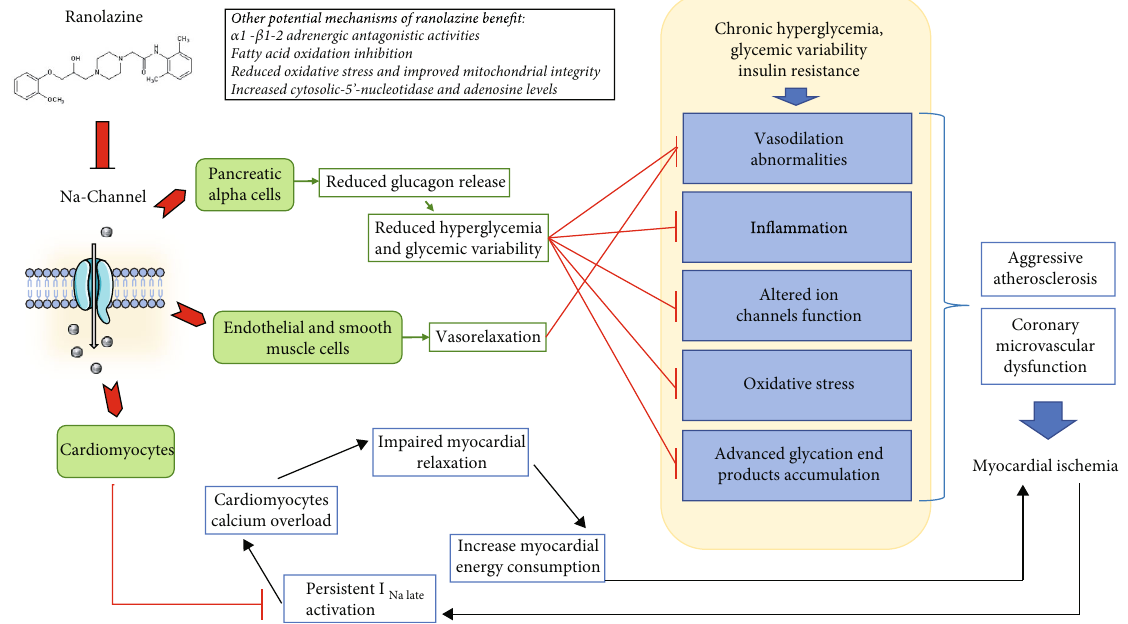
Figure 3: Mechanisms of ranolazine ’ s bene fi t in the diabetic